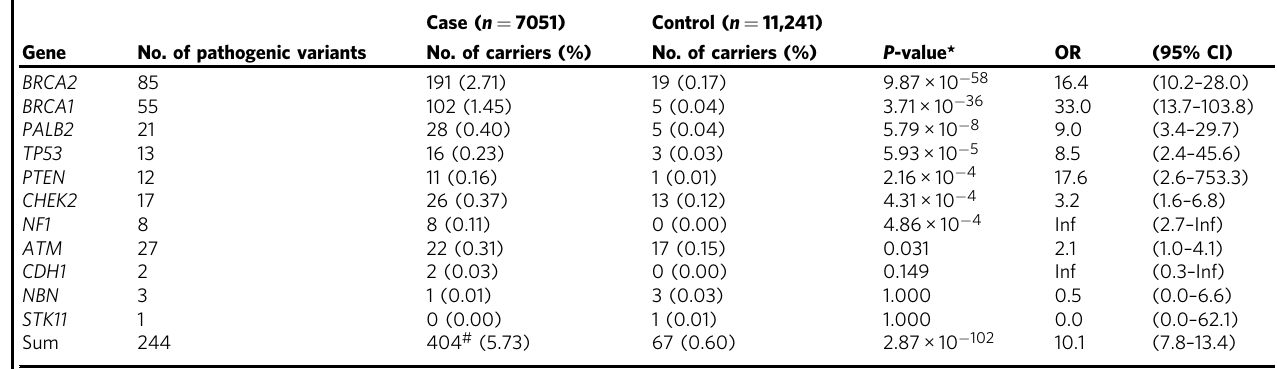
Table 2 Result of gene-based association test using pathogenic variants